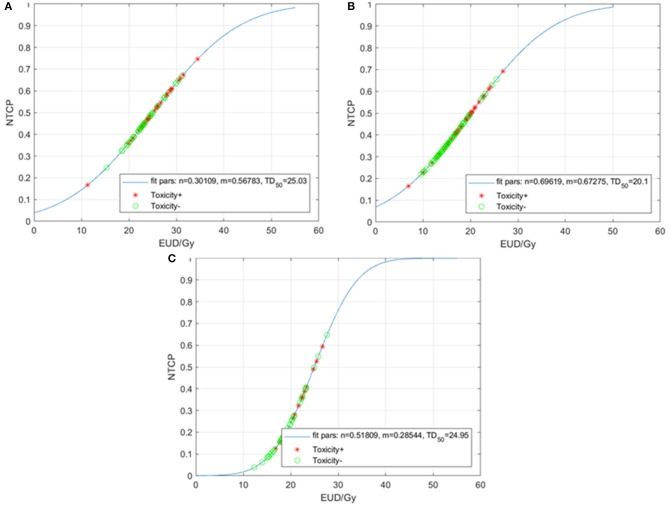
Normal tissue complication probability (NTCP) for acute grade ≥3 hematologic toxicities (HT3+) per the Lyman-Kutcher Burman model for all patients (A), patients treated with carboplatin/paclitaxel (B), and those treated with other systemic therapy regimens (C). Patients that experienced HT3+ during chemoradiation are represented by red asterisks; patients without HT3+ are represented by green circles. EUD, equivalent uniform dose.